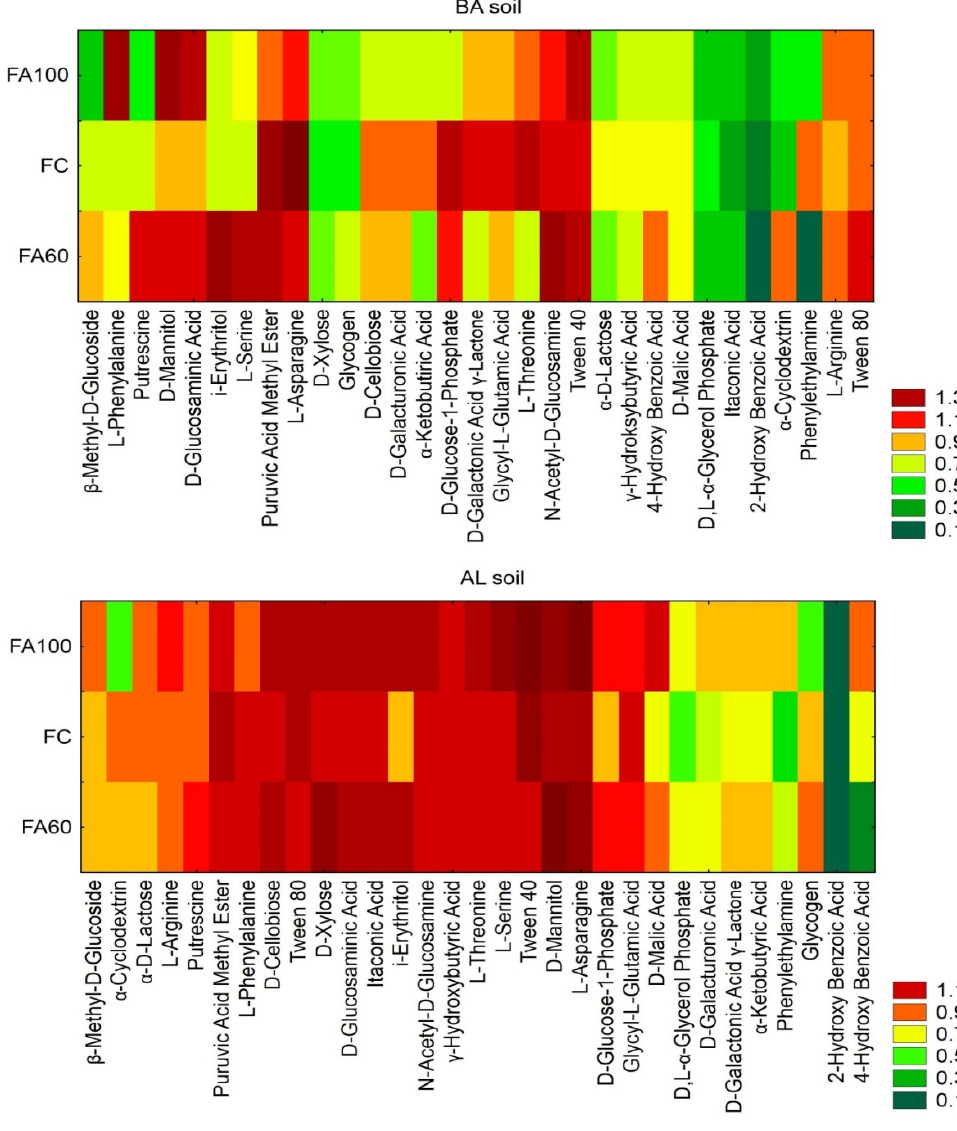
Figure 2. BIOLOG ECO TM plate carbon substrates utilization intensity diagrams. Explanation: BA— Brunic Arenosol, AL—Abruptic Luvisol, FC—optimal dose of fertilizer, FA100—optimal dose of fertilizer enriched with microorganisms, FA60—of fertilizer enriched with microorganisms (dose reduced by 40%).